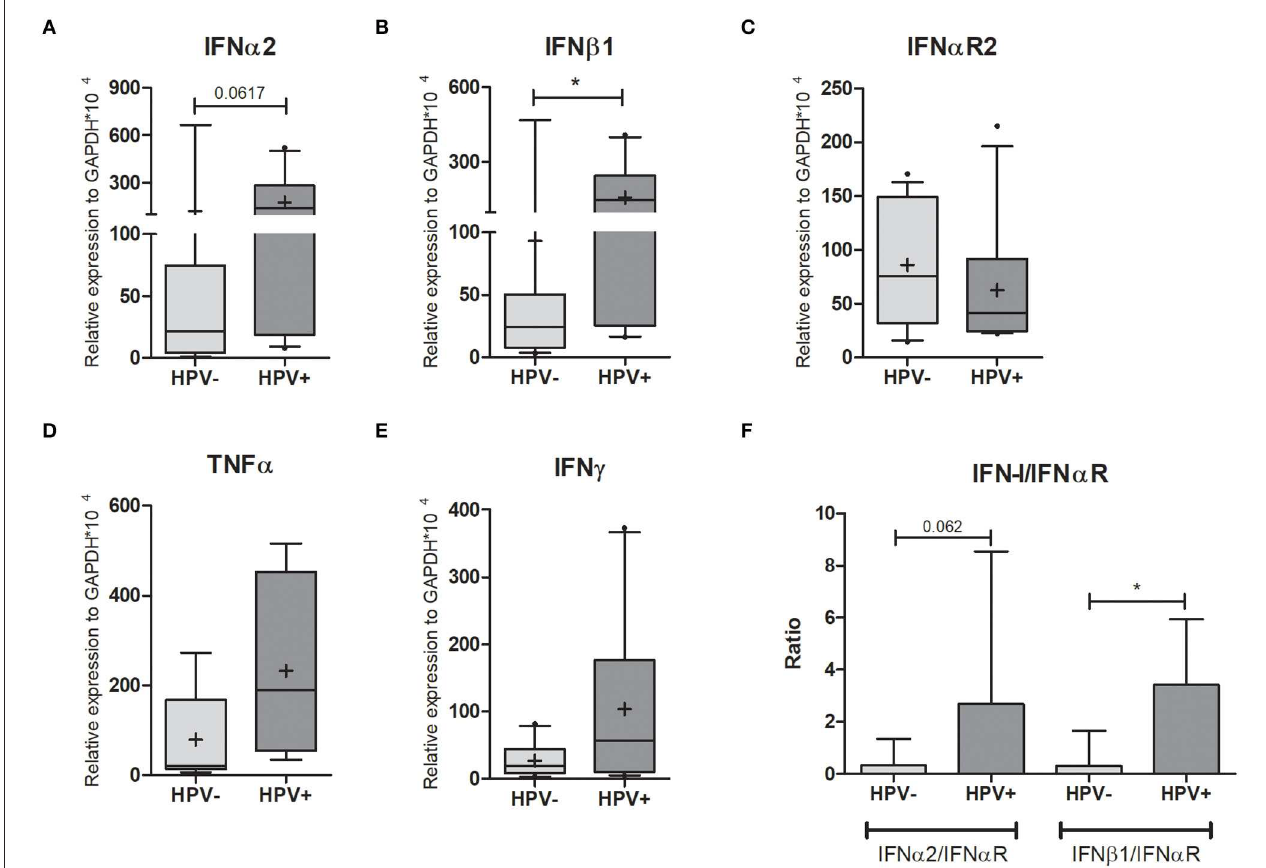
FIGURE 3 | Cytokine expression in cervical cells. Expression levels of (A) IFN α 2; (B) IFN β 1; (C) IFN α R2; (D) TNF α , and (E) IFN γ relative to GAPDH expression. Box plots represent 10–90 percentiles; dots represent outlier sample; “ + ” represents the mean and the horizontal bar, the median. In (F) the IFN-I/IFN α R2 ratios are presented in a histogram depicting medians and with interquartile range. HPV- = 15 and HPV + = 11 women (A,B,C,F) ; HPV- = 8 and HPV + = 4 women (D) ; HPV- = 10 and HPV + = 10 women (E) . Mann-Whitney U -test; * p ≤